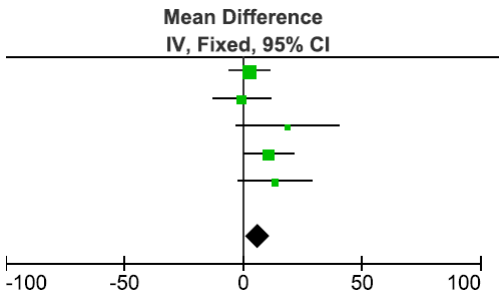
Figure 4. Meta ‐ analysis: mean differences in DIT between bolus vs. smaller frequent meals event (such as snacking). Studies included in this meta ‐ analysis are represented in the figure by symbols (green squares) and they are illustrated in the following order: Kinabo and Durbin et al. [32] ‐ Paper B low CHO, high fat meal ‐ 37.6% Weight; Kinabo and Durbin et al. [32] ‐ Paper B high CHO, low fat meal ‐ 19.0% weight; Vaz et al. [34] ‐ 6.0% weight; Allirot et al. [35] ‐ 25.5% weight; Tai et al. [27] ‐ 11.8% weight. Weight refers to amount of influence that the study exerts on the meta ‐ analyses. The % contribution of each study to the outcome is indicated as % weight.